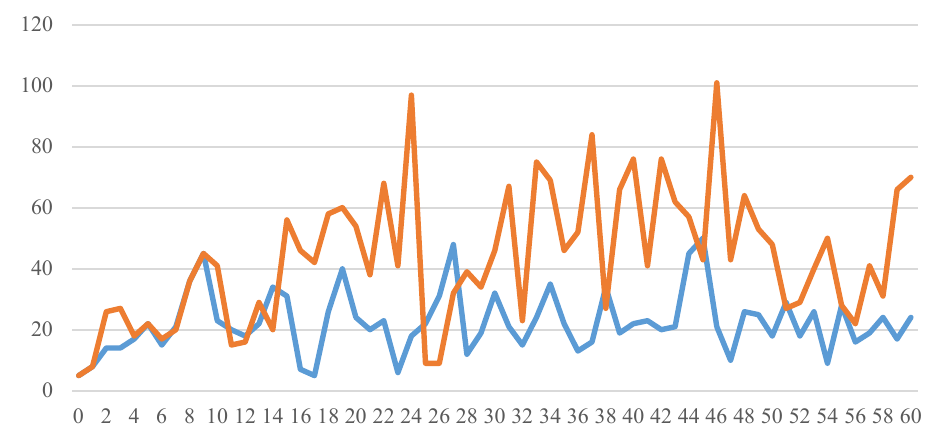
Fig. 5 Interpretation of Engagement and Market Share